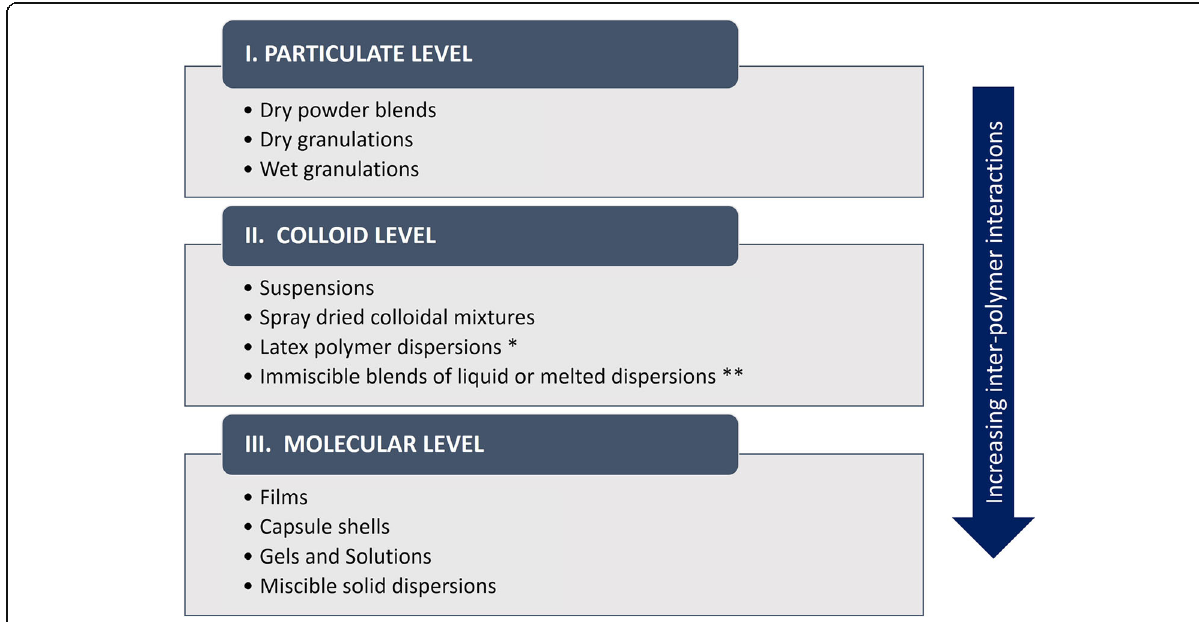
Fig. 3 Polymer blend processing/mixing level classification. Examples reflect the level to which the polymers used have been processed. Single sterisk indicates that depending on process conditions and polymer miscibility, latex dispersions can coalesce and become molecular level blends. Double asterisk indicate that immiscible or partially miscible blends with colloidal size aggregates, which an arise from (i) process conditions not dispersing polymers to the molecular level or (ii) polymers demixing during processing (e.g., two immiscible polymers demixing from a common solvent during drying of a